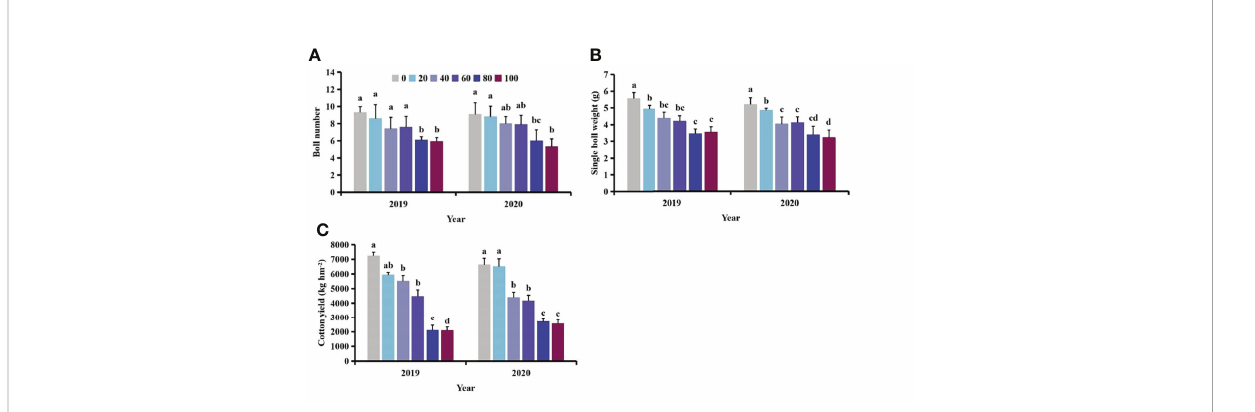
FIGURE 4 Effects of different Scirpus planiculmis densities on cotton (A) boll number, (B) single boll weight and (C) cotton yield. The mean value ± standard data were presented in the fi gure. Different alphabetical letters indicate the signi fi cant differences between different S. planiculmis density ( p <0.05).